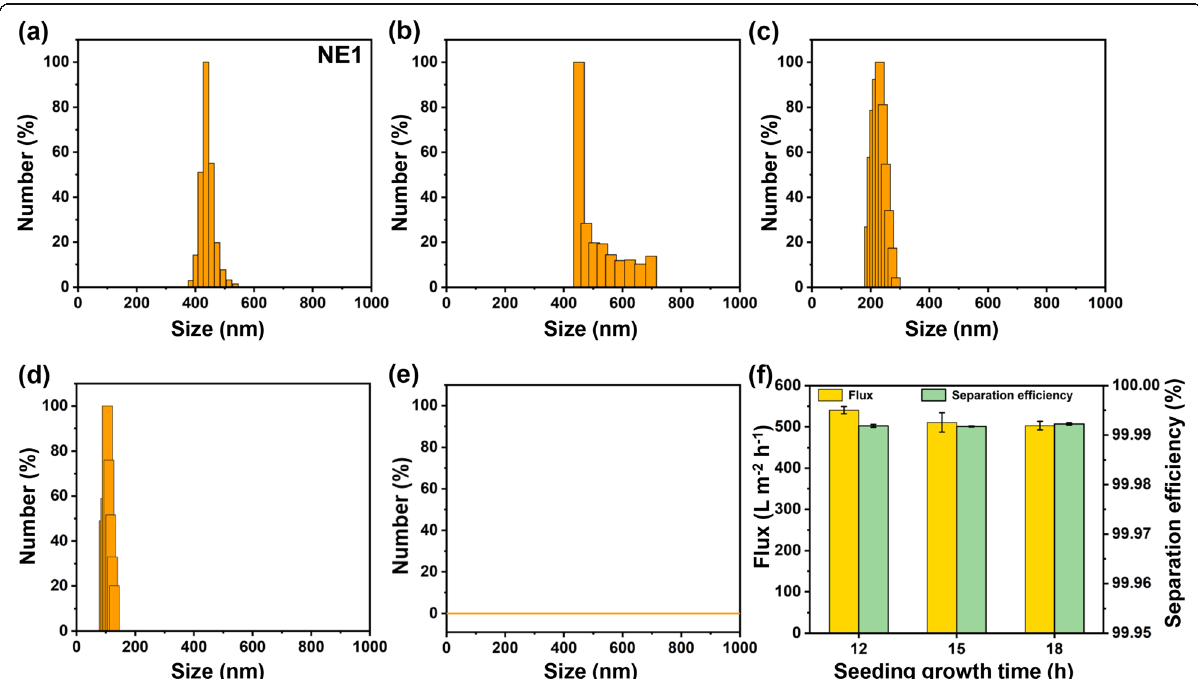
Fig. 2 DLS curves of NE1 before ( a ) and after the separation by the double-layer CFM/UiO-66( x )/PDMS membranes that were prepared by seeding growth of UiO-66NPs for: 3.0 h ( b ), 6.0 h ( c ), 9.0 h ( d ) and 12 h ( e ), respectively, fluxes and separation efficiencies to NE1 separated by the double-layer CFM/UiO-66( x )/PDMS membranes with different seeding growth time of UiO-66NPs ( f